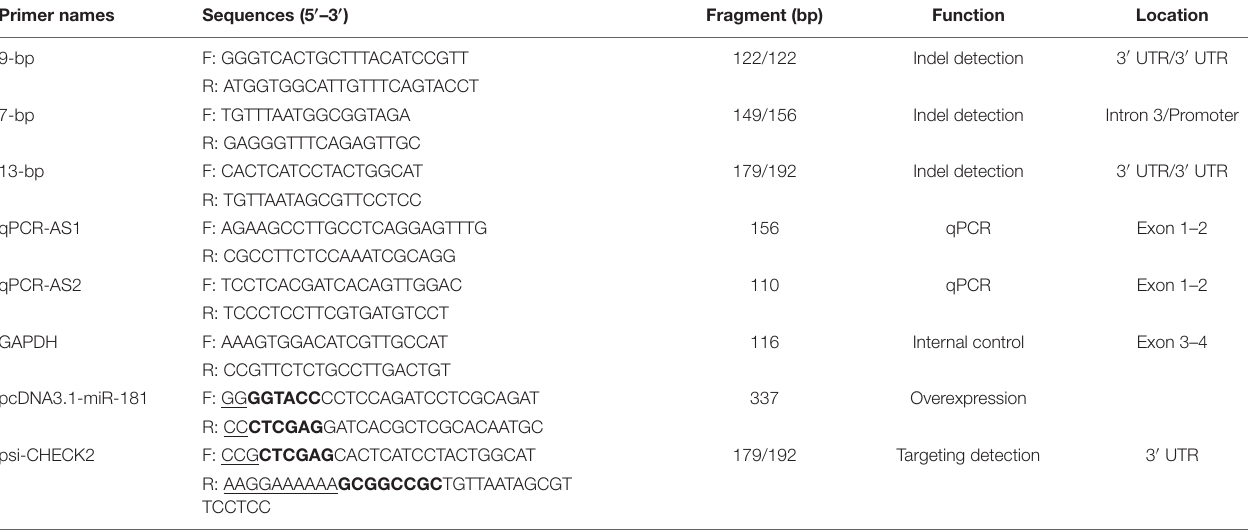
TABLE 1 | Primers for PCR